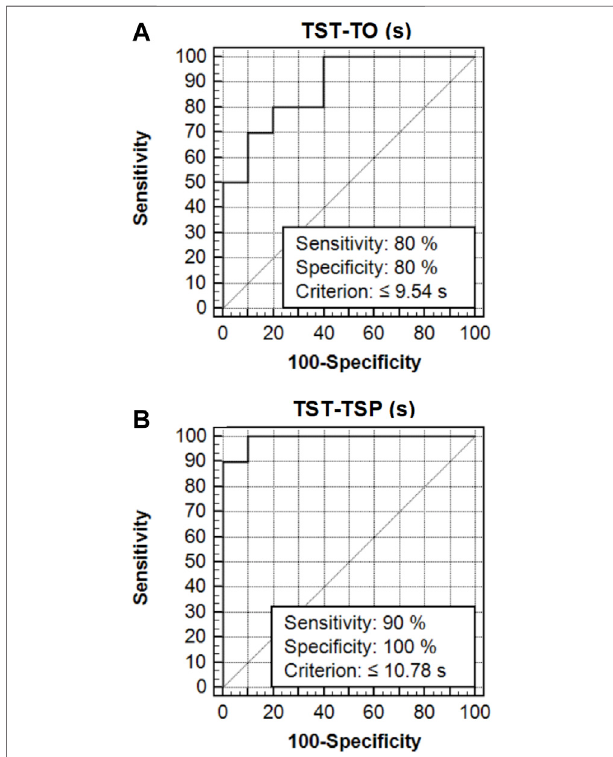
FIGURE 2 | ROC curves for the TST performance for top-elite and elite taekwondo athletes. (A) : TST-TO (s); (B) : TST-TSP (s); TST: Taekwondo speci fi c change-of-direction speed test with striking techniques; TST-TO: TST-time-only; TST-TSP: TST-time with striking penalty; ROC: Receiver operating